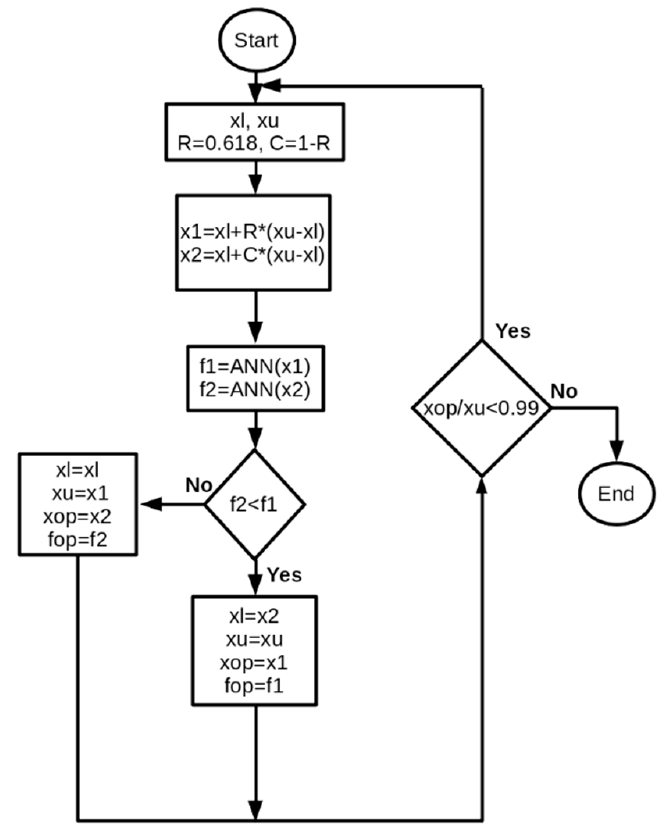
Figure 3. Flowchart of the golden section method.